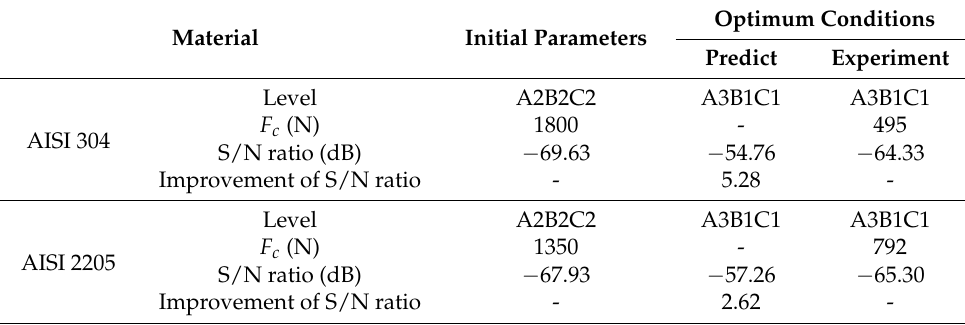
Table 12. Results of the confirmation experiment for cutting force.